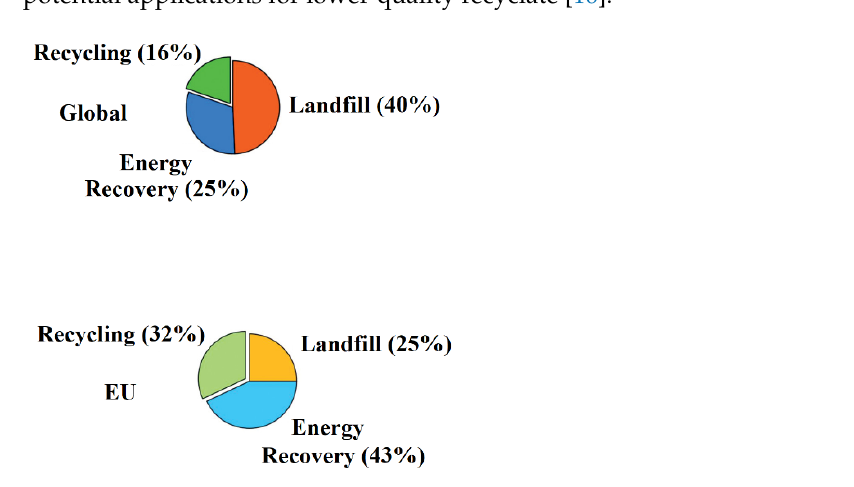
Figure 6. Using novel blending approaches to upscale properties of recycled PO blends using mi- crofibrillar PET ( a ), ( c ) Using conventional injection molding (CIM), ( b , d ) Using multi-flow viber injection molding (MFVIM). Reprinted with permission from ref. [16]. Although MR is essentially an environment-friendly and economically sustainable protocol for plastics recycling, the real costs of existing MR processes are still ineffective. Furthermore, MR presents a recovery limit as the mechanical properties degrade with each cycle leading to nth-generation products with inconsistent quality [17]. 2.1.1. Conventional Mechanical Reprocessing MR generally involves precleaning, sorting plastics by type, shredding, melt extru- sion, and remolding plastics, including PS. Interestingly, HIPS is well suited for MR, since little degradation in mechanical properties is observed after multiple cycles of repro- cessing [18]. The basic washing and then drying encompass the precleaning stage. The